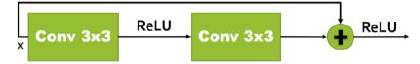
Figure 3: The encoder block of DRU-Net (Jafari et al., 2020)